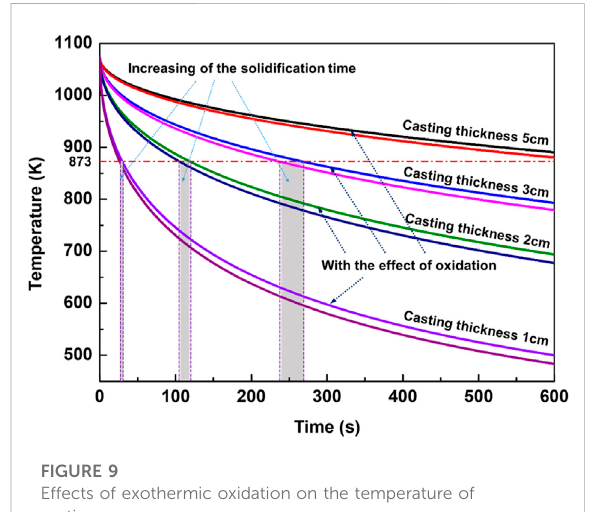
FIGURE 9 Effects of exothermic oxidation on the temperature of castings.